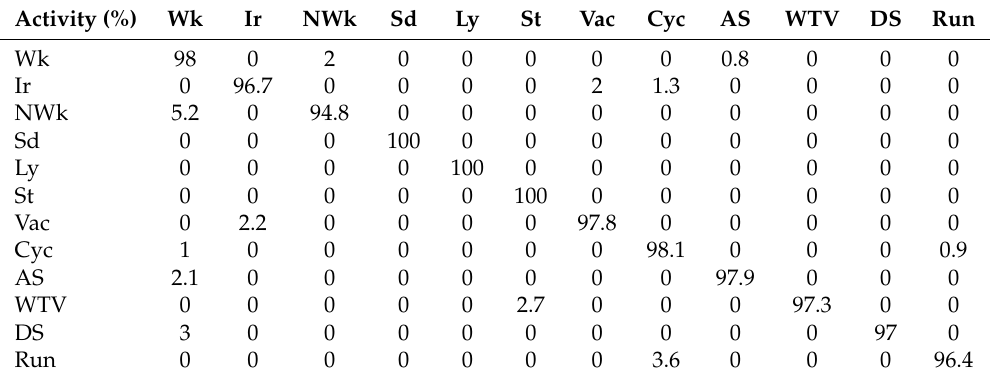
Table 5. Confusion matrix of the CNN-GRU